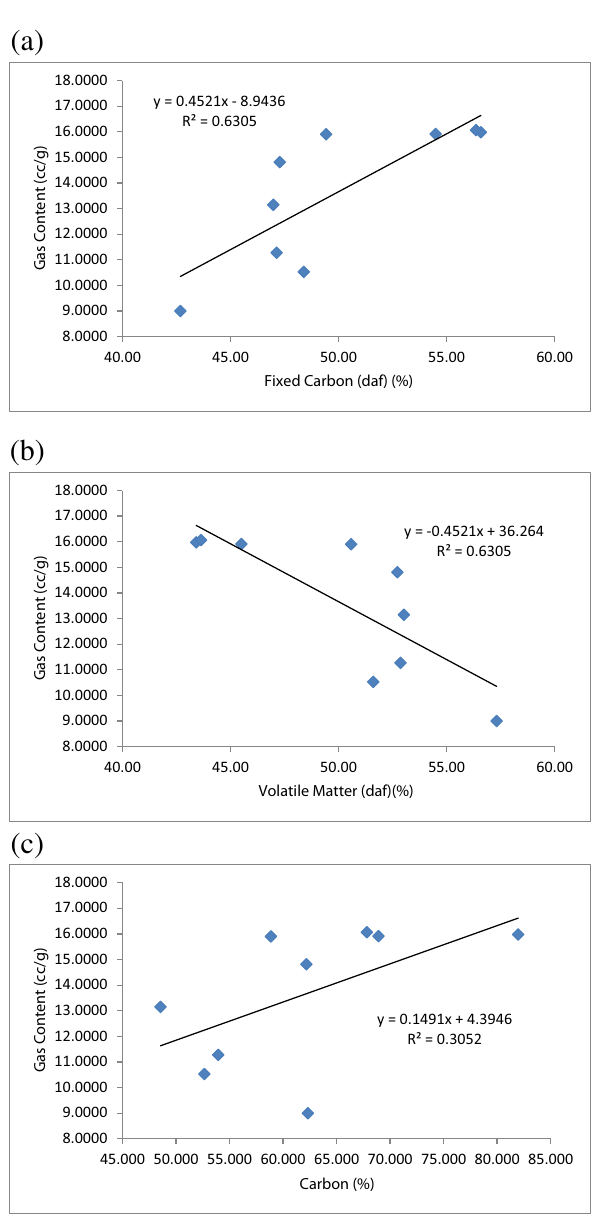
Fig. 3 a Variation in gas content with fixed carbon (dry ash free). b Variation in gas content with volatile matter (dry ash free). c Varia- tion in gas content with carbon percentage